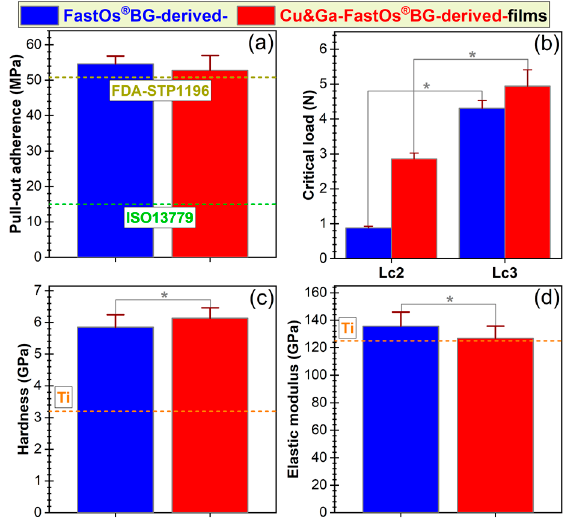
Figure 6. Summary of the mechanical performance of the SBG films in terms of ( a ) pull-off bonding strength (tensile), ( b ) scratch resistance, ( c ) hardness and ( d ) elastic modulus. * p < 0.05, statistically significant differences, as determined by using an unpaired two-tailed Student’s t -test.